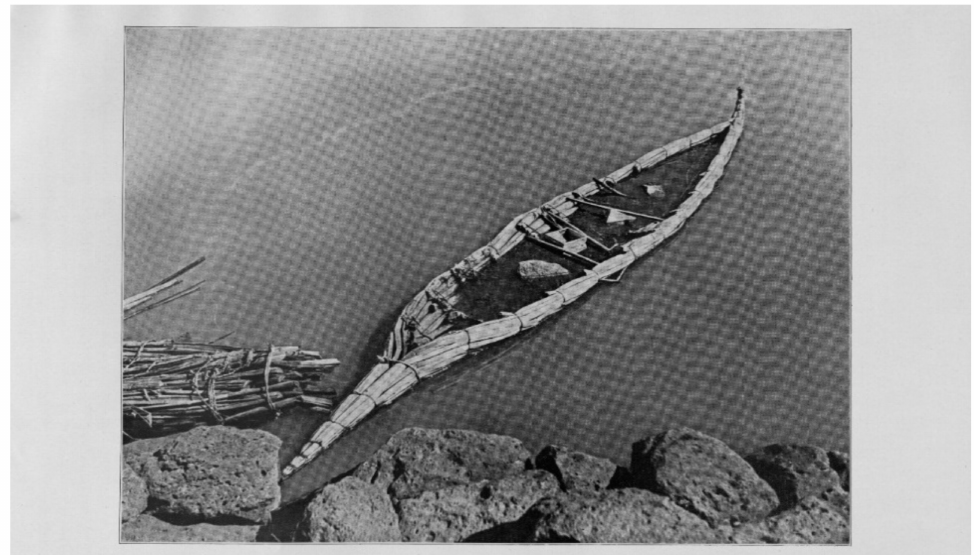
Figure 5. The photograph taken in 1920 shows a tank evaporimeter floated on a Tankua (a locally made tiny boat) on Ifwadda Lagoon nearby Lake Tana outlet. It was used by sinking the Tankua to about 5 cm and anchoring it with rocks to maintain temperature equality between inside and